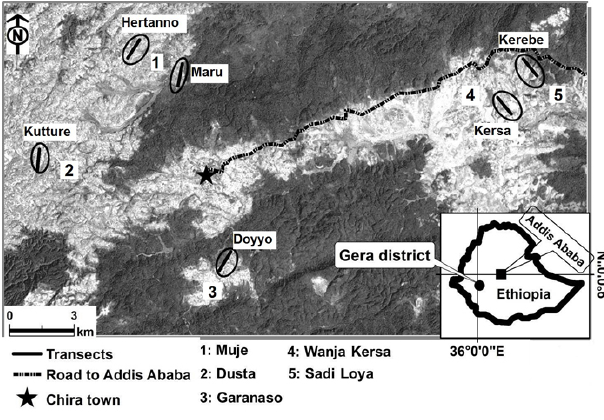
Fig. 1 . Map of the study area. Villages are indicated by circles around the transects (1 km in length, and traversed mostly by croplands, grazing fields, and home gardens). All the surveyed fields are located within these circles. The numbers listed on the map and the corresponding names in the legend represent the kebeles , the lowest administrative unit in Ethiopia and made up of a number of villages, to which the studied villages belong. The darker grey areas show forest and semimanaged forest coffee, and lighter grey areas show cultivated and settled areas (background map based on a Landsat scene from